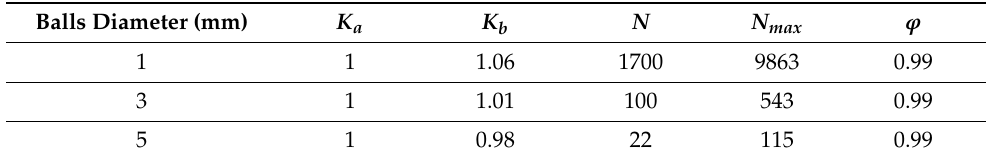
Table 2. Parameters and factors of milling balls calculated according to [21,22], K a —constant describ- ing elastic and inelastic properties of collision, K b —ball-size related geometrical coefficient, N —the number of balls, N max —number of balls for maximum fulfillment of the vial, ϕ —fulfillment factor. Balls Diameter (mm) K a K b N N max ϕ 1 1 1.06 1700 9863 0.99 3 1 1.01 100 543 0.99 5 1 0.98 22 115